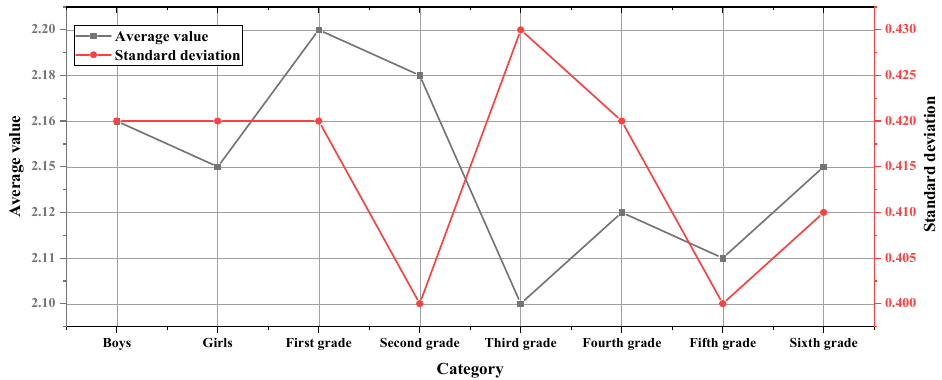
Figure 5. The differences in positive psychological emotions for gender and grade.